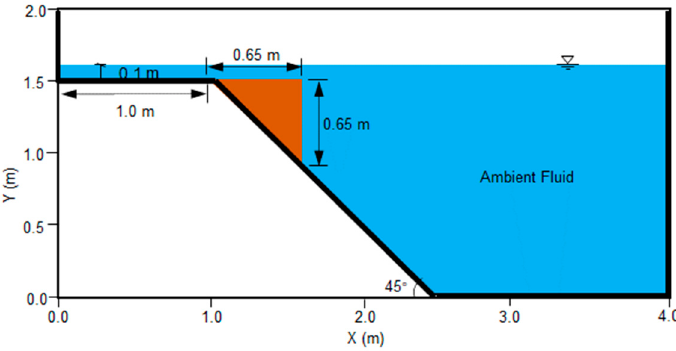
Figure 9. Experimental setup of the underwater sand flow.